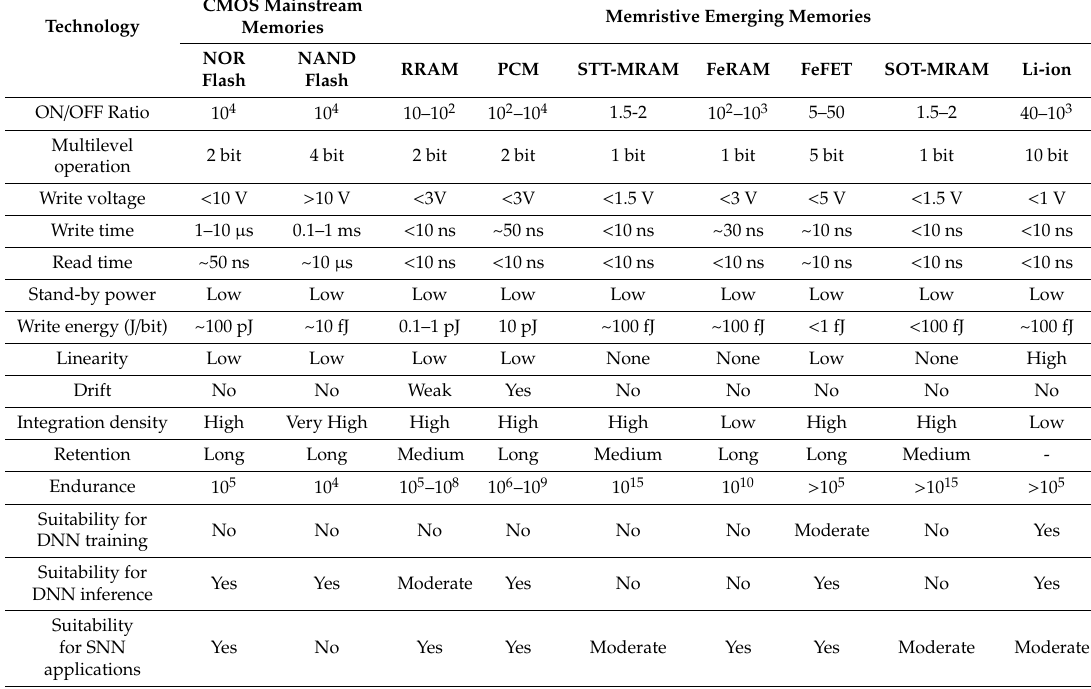
Table 1. Comparison of key features exhibited by CMOS mainstream memory devices and memristive emerging memory devices under investigation to implement neuromorphic computing in hardware. Adapted from